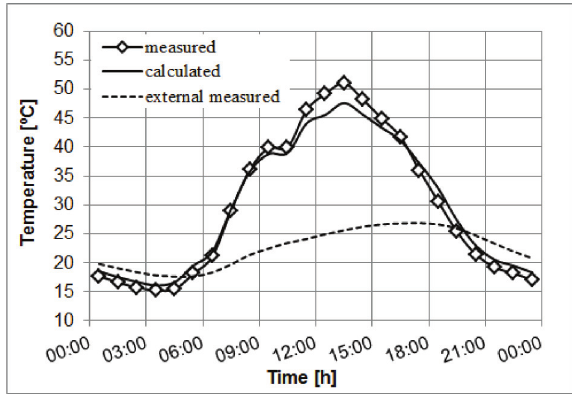
Fig. 6a. average hourly temperatures of ventilated air gap and external